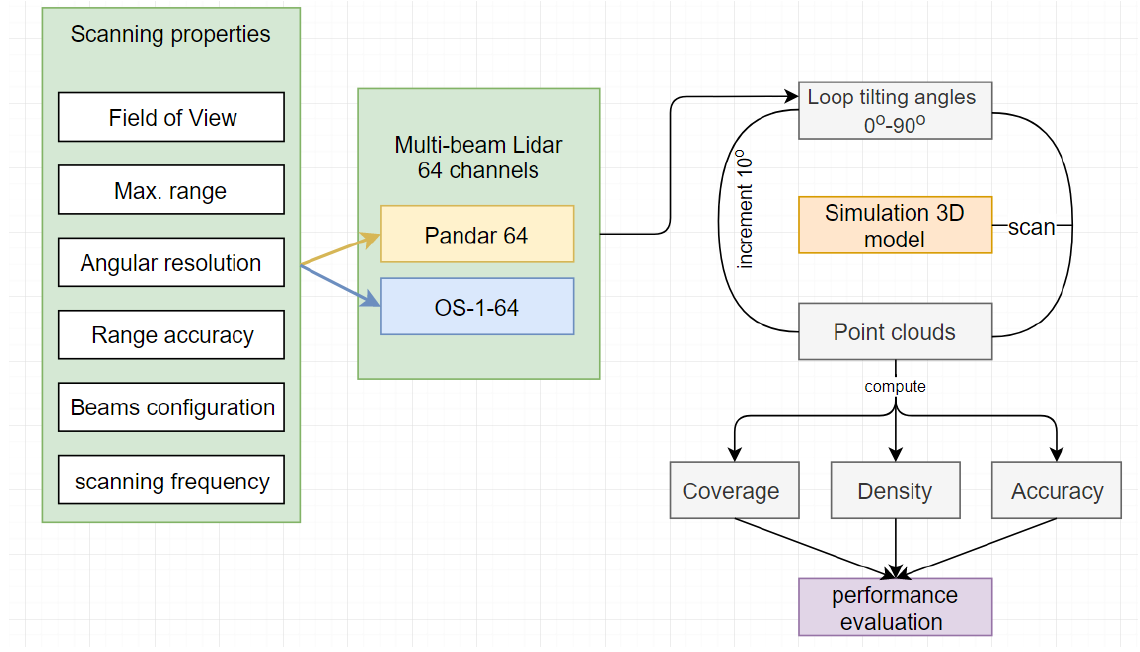
Figure 3. Methodology workflow.